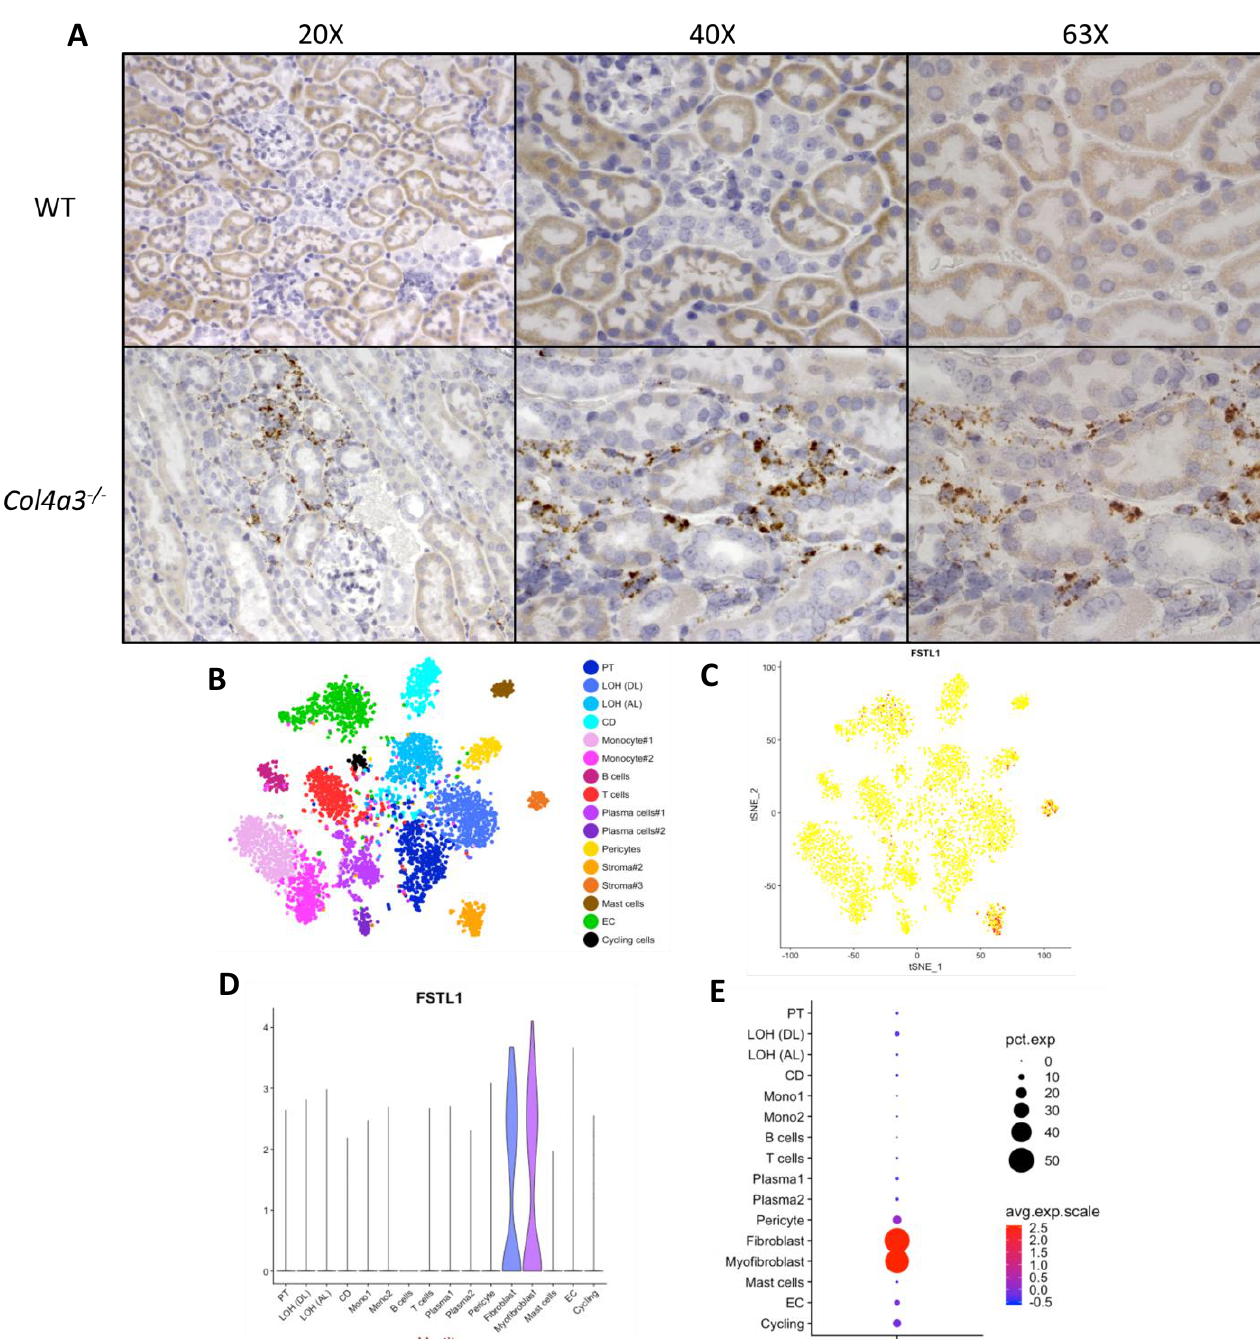
Figure 7. Fstl1 expression localization in the kidney. ( A ) Light microscopic images at three magnifications of RNAscope ® Fstl1 localization in wild type mice (upper three panels) and Col4a3 −/− mice (lower three panels). ( B – E ) Cell Clustering and Fstl1 expression from the Kidney Interactive Transcriptomics (KIT), human rejecting kidney allograft biopsy cells (http://humphreyslab.com/SingleCell, accessed on 15 March 2021).